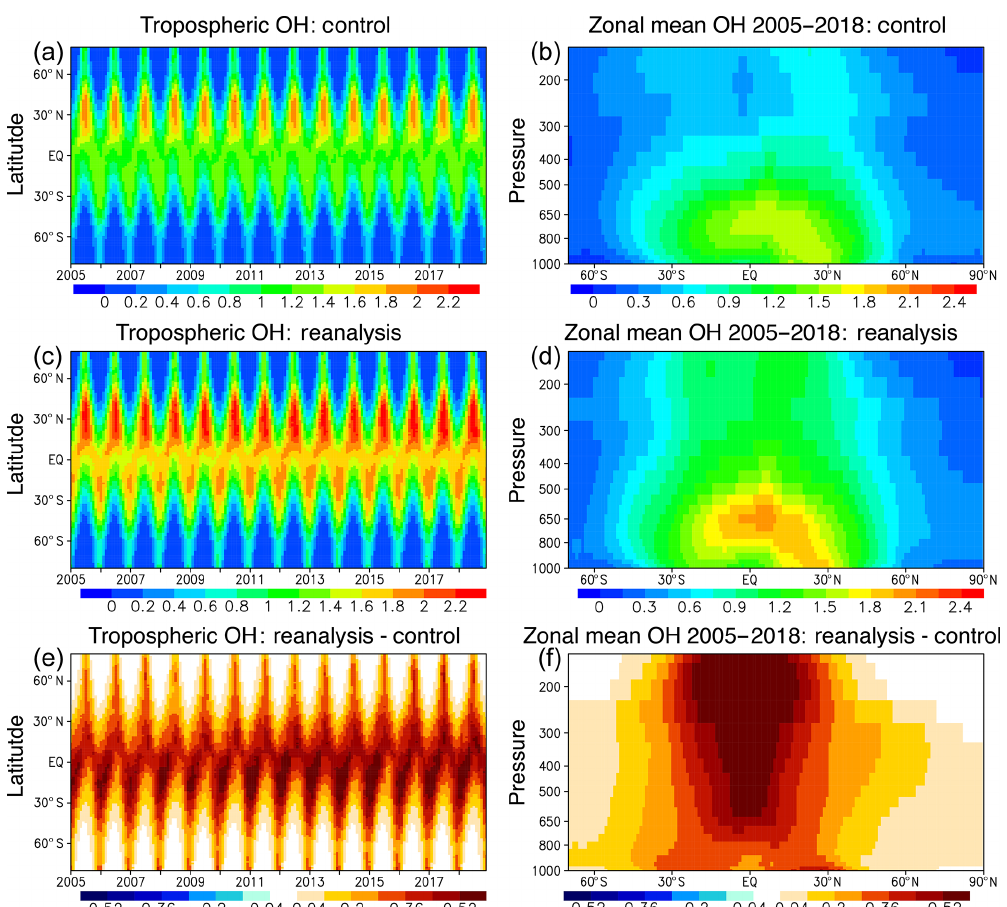
Figure 9. Latitude–pressure cross section of the mean OH concentration (b, d, f) averaged during 2005–2018 and time–latitude cross section of the monthly mean OH concentration averaged between the surface and 300hPa (a, c, e) . The mean OH concentrations from the control run (a, b) , reanalysis (c, d) and the difference between the reanalysis and the model simulations (e, f) are shown. Units are 10 4 moleculescm − 3